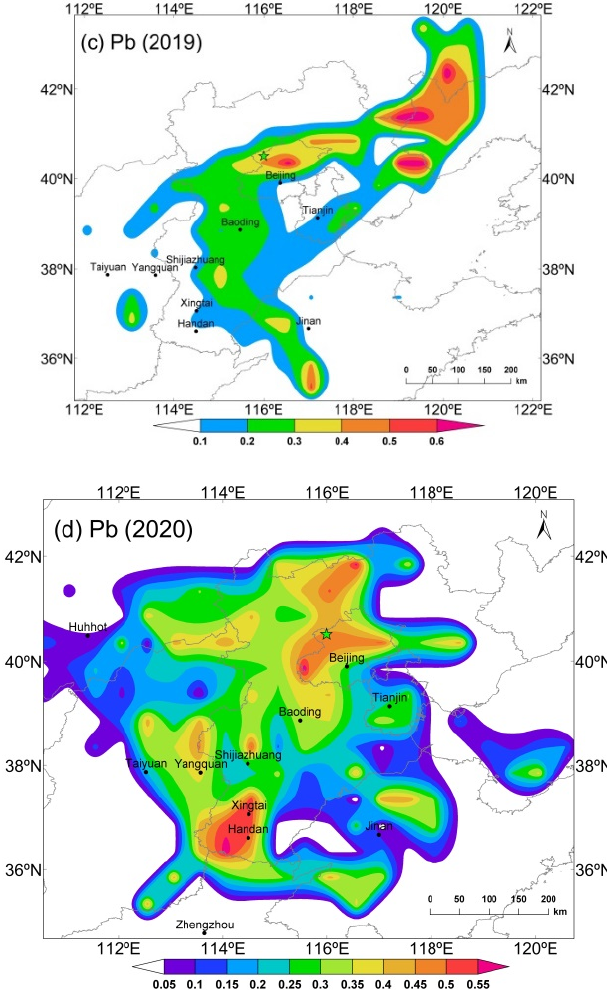
Figure 5. The potential source regions of atmospheric bulk Pb depositions according to potential source contribution function (PSCF) analysis in 2017 ( a ), 2018 ( b ), 2019 ( c ) and 2020 ( d ).